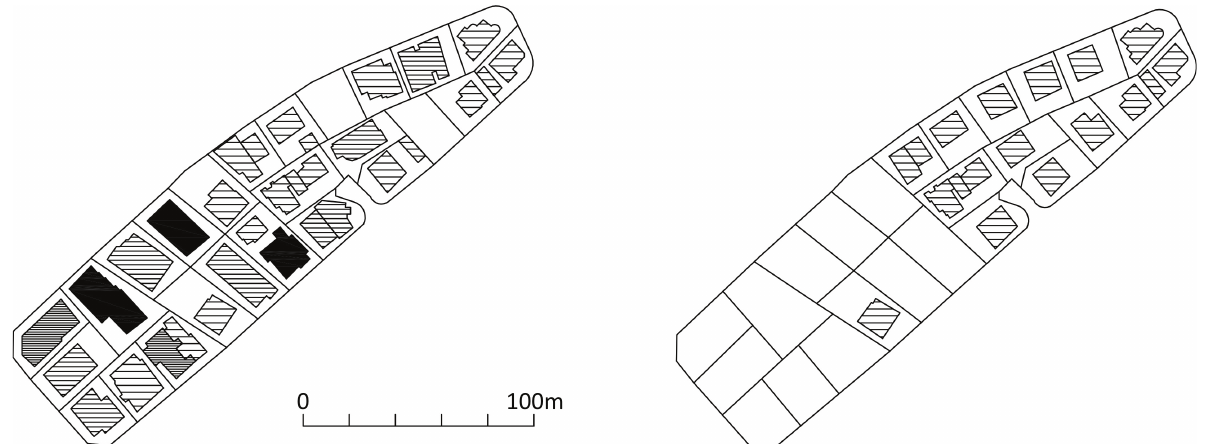
Figure 4. Suburban block heights—from lighter to darker hatch: 1 to 4 floors. Today (left), 1963